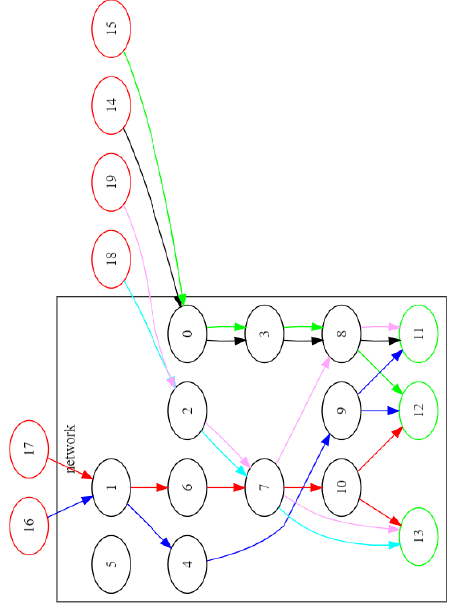
Figure 7. Instance case3 MIP result.